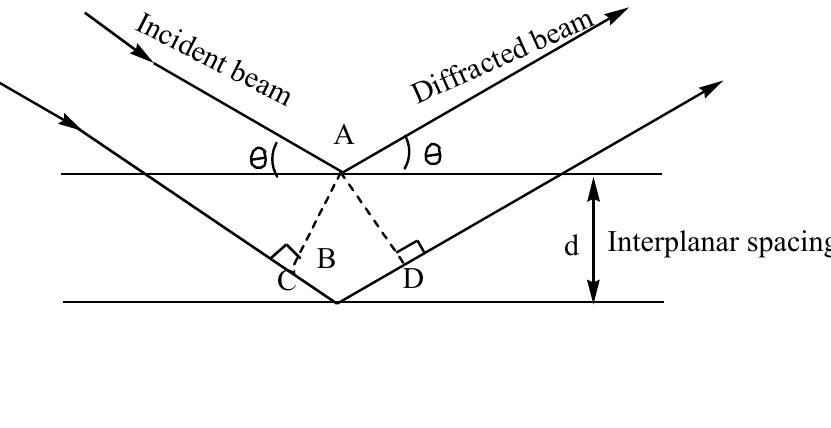
Fig. 1. Diffraction of X-rays by crystal